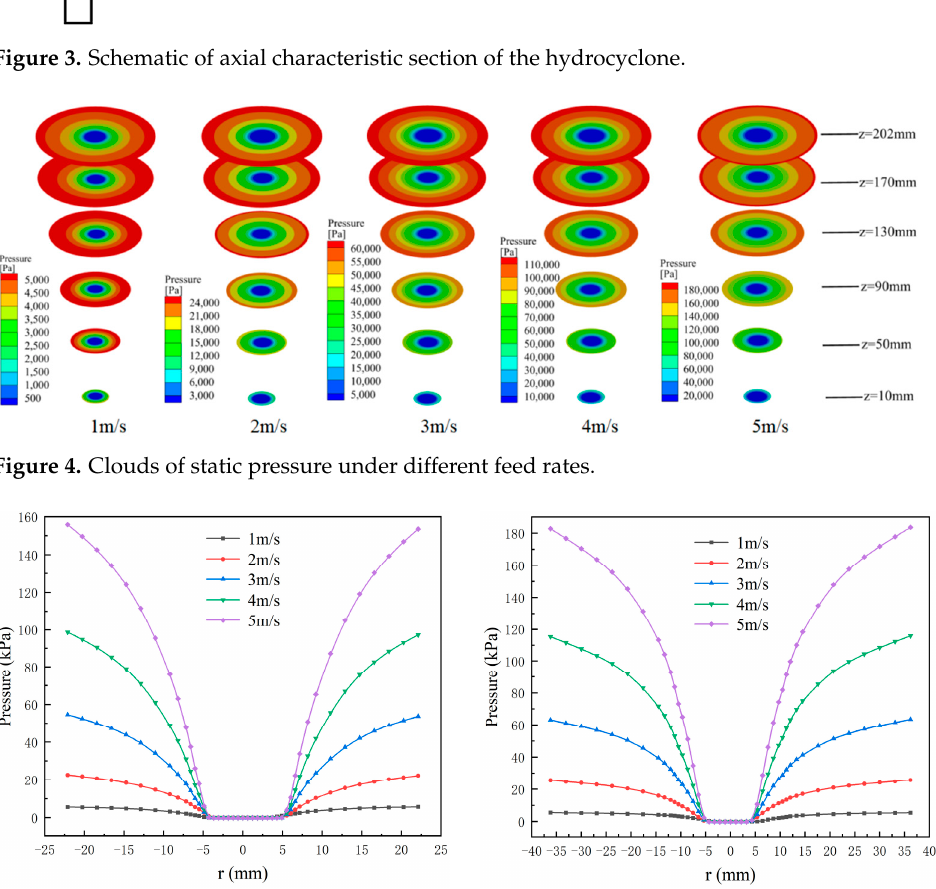
Figure 4. Clouds of static pressure under different feed rates . Figure 5. Distributions of the static pressure . ( a ) z 1 = 90 mm; ( b ) z 2 = 170 mm . Figure 5. Distributions of the static pressure. ( a ) z 1 = 90 mm; ( b ) z 2 = 170